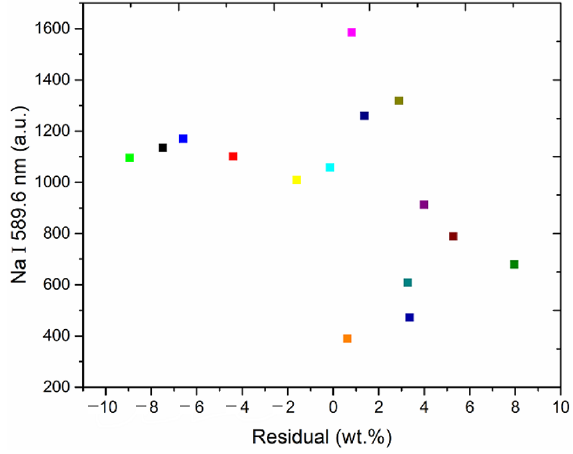
Figure 9. Plot of the average of the residuals of 100 spectra of each modelled sample against the average of the intensities of the most important spectral lines (Na Ⅰ 589.6 nm).